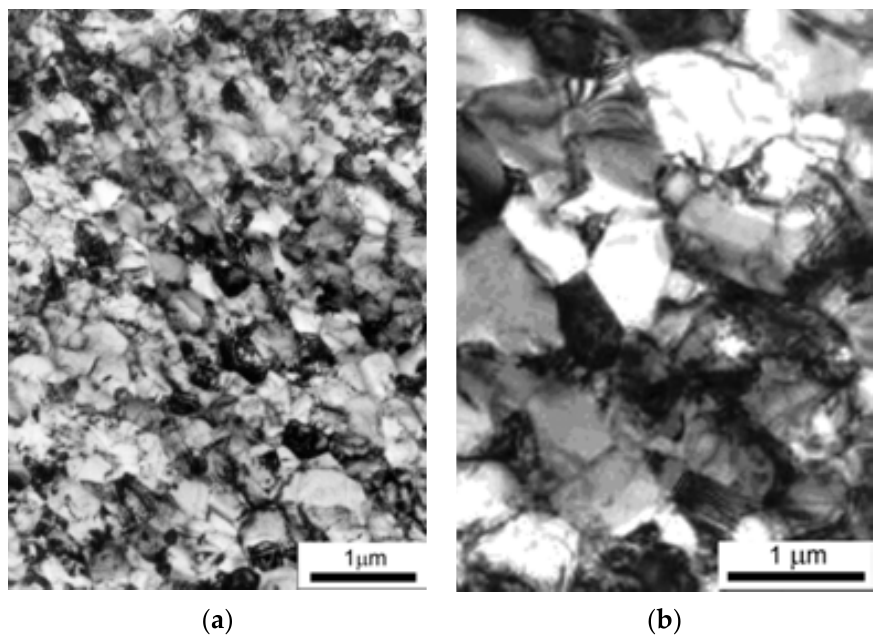
Figure 3. Microstructure of AISI-304 steel after straining by HPT: ( a ) at cryogenic temperature; ( b ) at room temperature. room